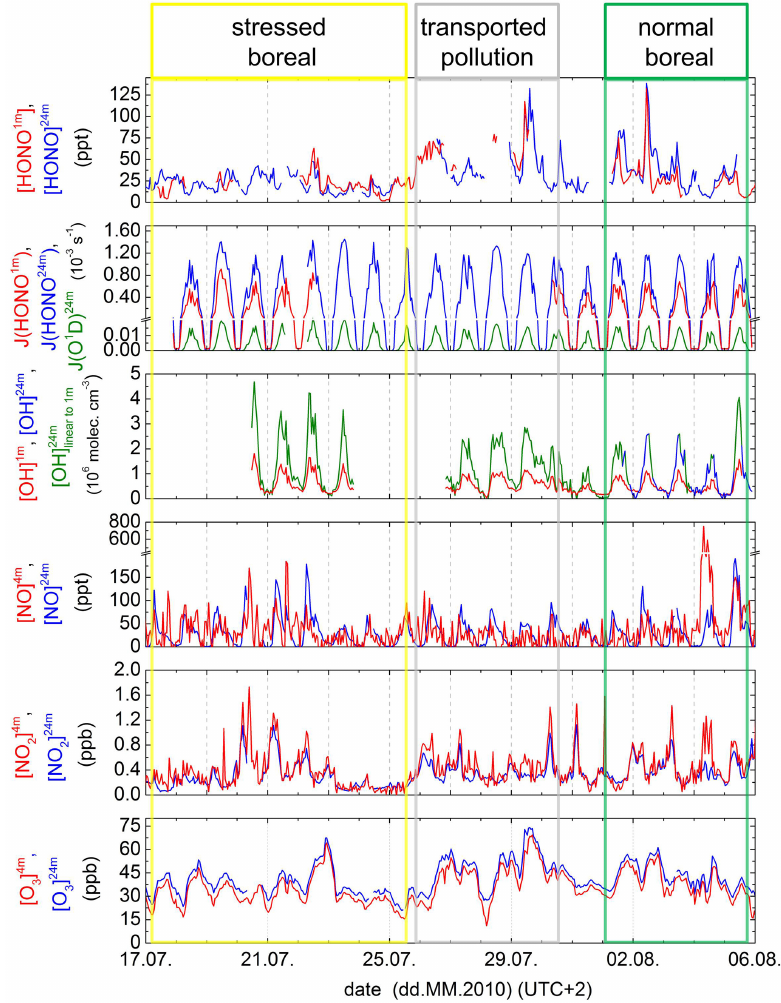
Figure 1. Overview of the measured concentration of different trace gases and the photolysis frequencies J( HONO ) and J (O 1 D). The linearly connected data points represent 60min average values. Mixing ratios or concentrations are shown for the period where HONO was measured at both heights. [OH] 24m was used to fill the gaps in OH measurements above the canopy (see Fig. 2a). Coloured boxes linear to 1m mark the respective regimes of “normal boreal” (green), “stressed boreal” (yellow) and “transported pollution”